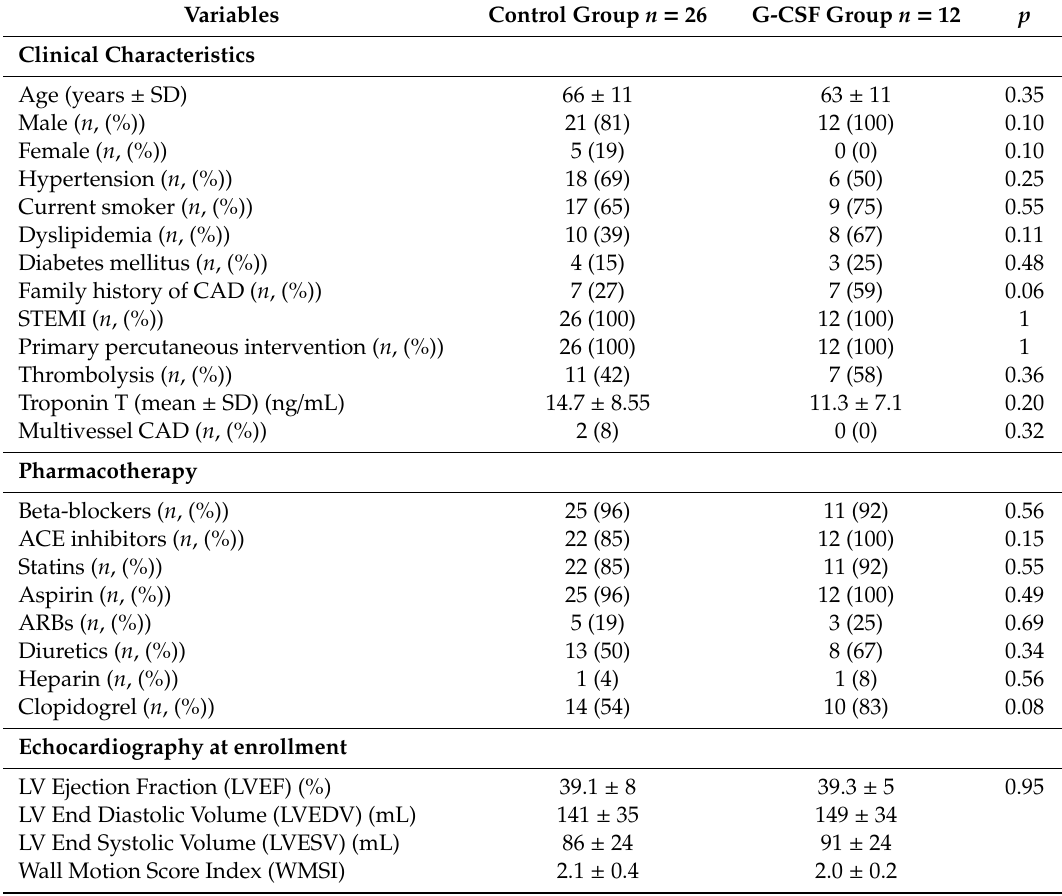
Table 1. Baseline clinical, medications and echocardiography characteristics of patients randomized to control standard-of-care vs patients randomized to granulocyte-colony stimulating factor (G-CSF) treatment at 10-year follow-up.